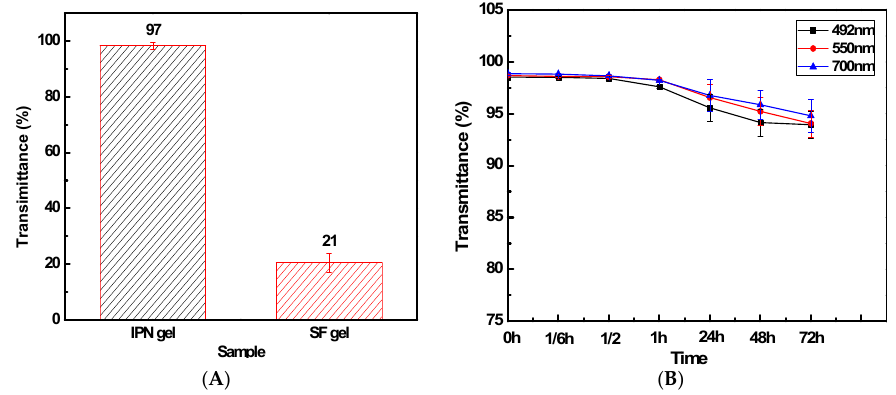
Figure 4. Light transmittance ( A ) at 550 nm. ( B ) IPN hydrogel transmittance at different times; The solid content of IPN hydrogel was 10 g/L, SF:NVP was 8:2 and the thickness of material was 4.4 mm.